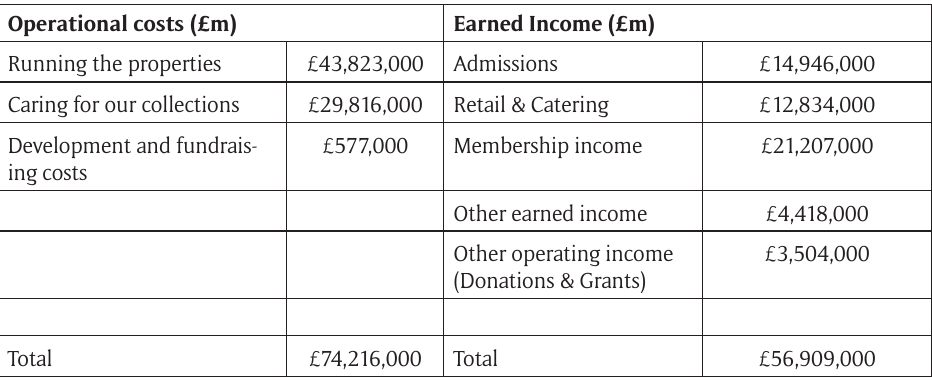
Table 1: Basic revenues for English Heritage, 2012/13 (this accounts sheet is modelled on those found in the organisation’s annual reports, see, for example, EH 2013b: